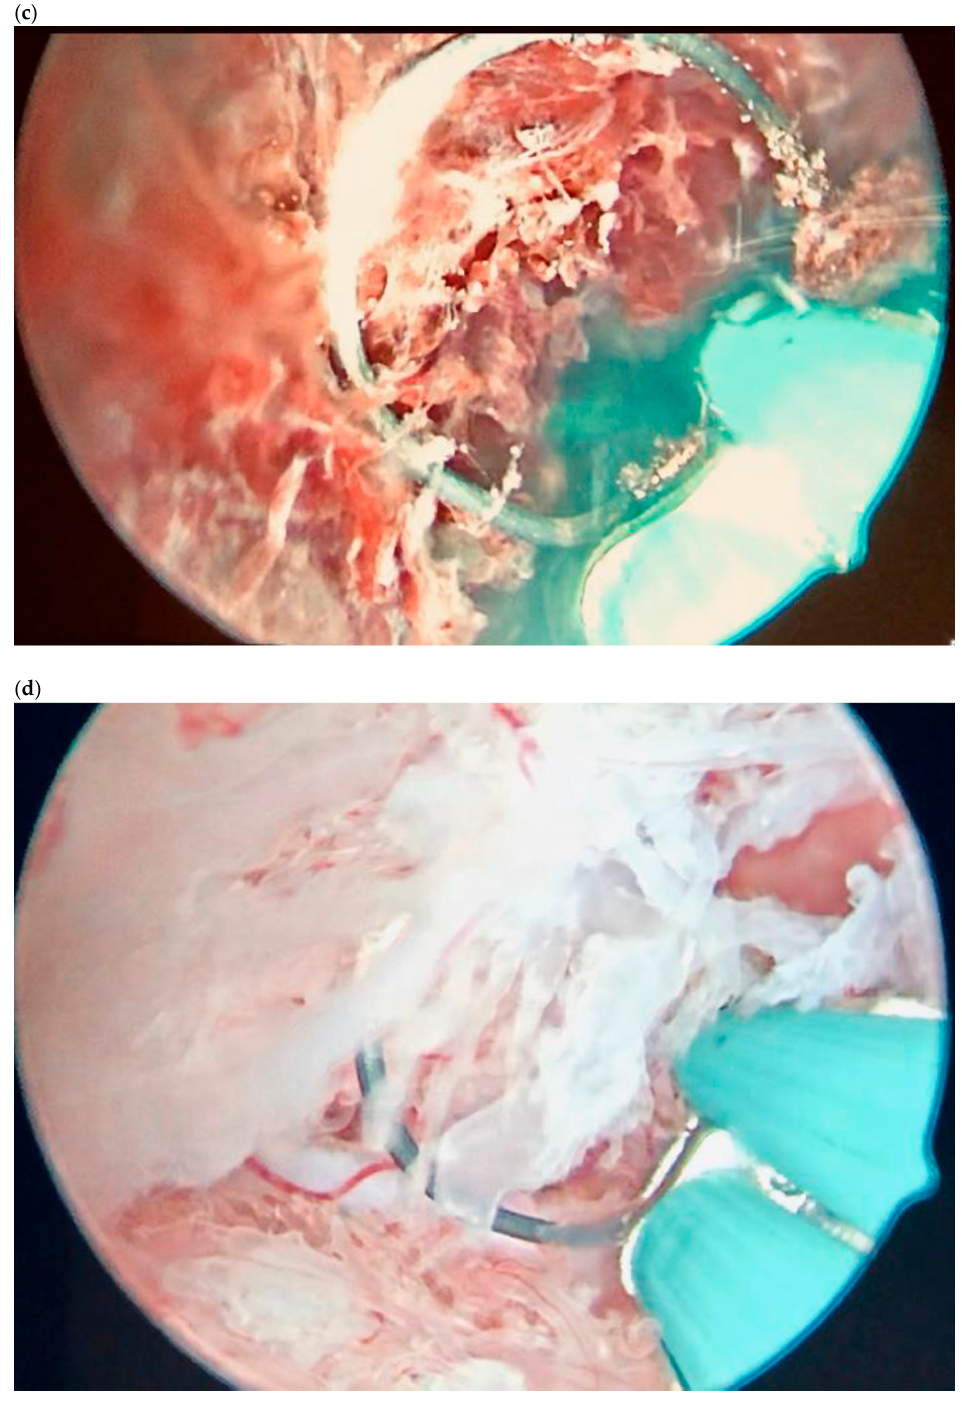
Figure 6. Hysteroscopic view of a scar pregnancy. ( a ) Embryo view. ( b ) Embryo coagulation by a bipolar electrode. ( c ) Resection of the trophoblast and its detachment from the myometrium. ( d ) Resection of the trophoblast and its detachment from the myometrium.